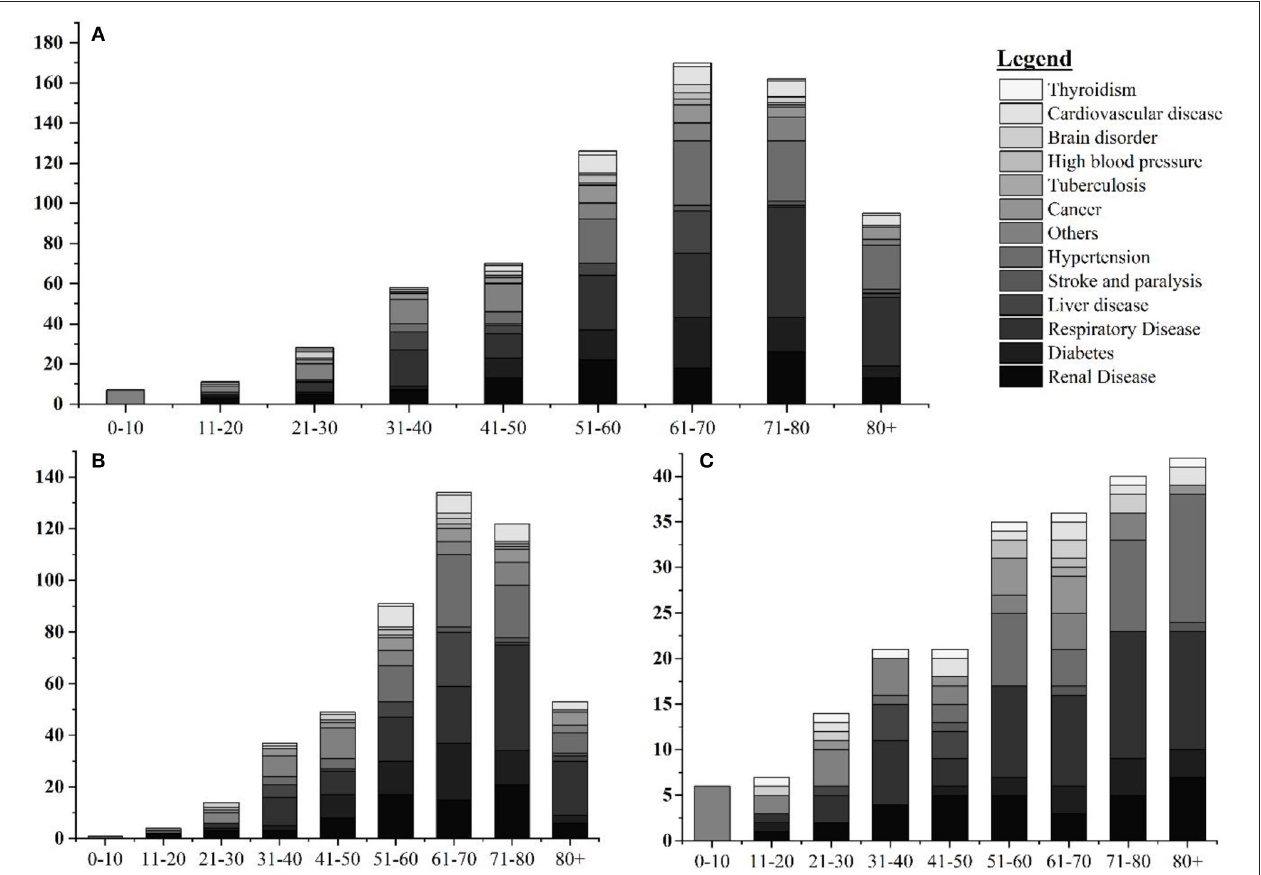
FIGURE 2 | Age and gender-wise distribution fatal cases with single comorbidities. (A) Age-wise distribution of leading single comorbidities among COVID-19 deaths; (B) age-wise distribution of leading single comorbidities among COVID-19 deaths in Nepal in male; and (C) age-wise distribution of leading single comorbidities among COVID-19 deaths in Nepal in